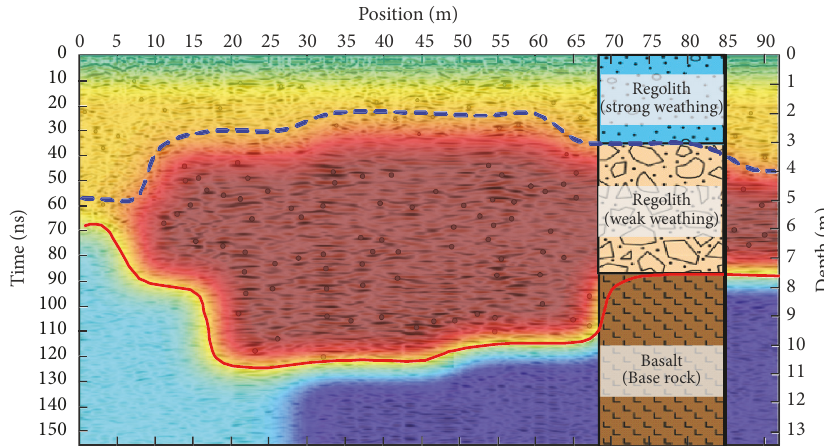
Figure 13: Interpretation of CH-2